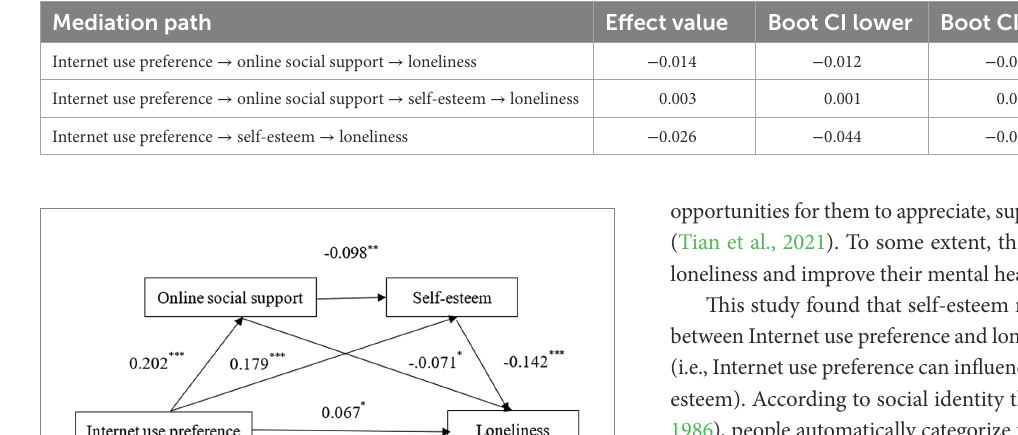
FIGURE 2 Chain-mediated pathway of online social support and self-